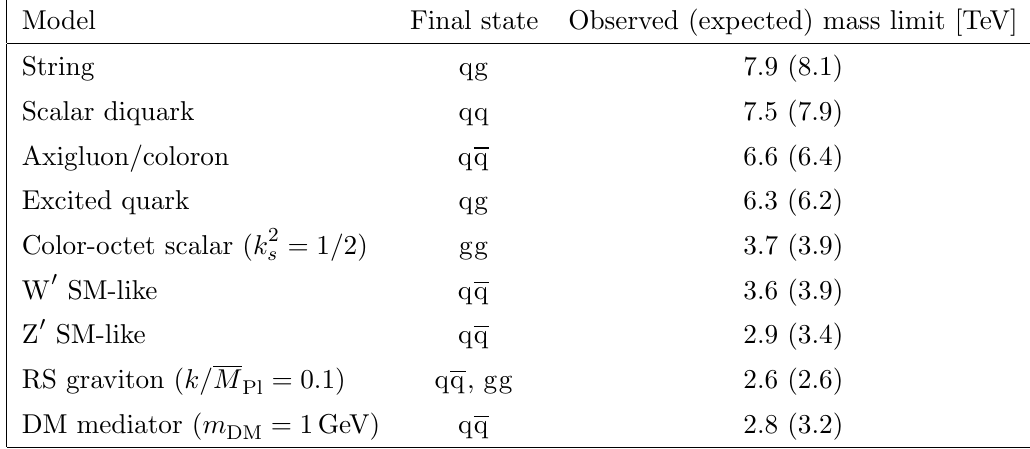
Table 1 . Observed and expected mass limits at 95% CL from this analysis. The listed models are excluded between 1.8 TeV and the indicated mass limit by this analysis. The SM-like Z 0 resonance is also excluded within the mass interval between 3.1 and 3.3